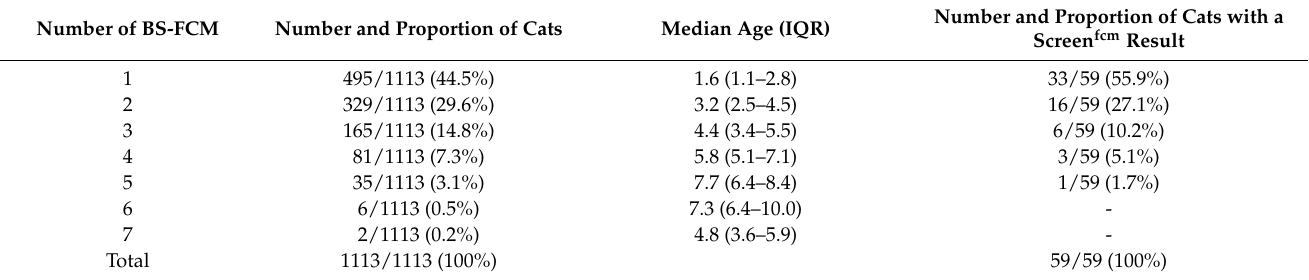
Table 3. Number of breed-screens performed per cat in the total study population, median age and interquartile range, and number and proportion of cats with a Screen FCM